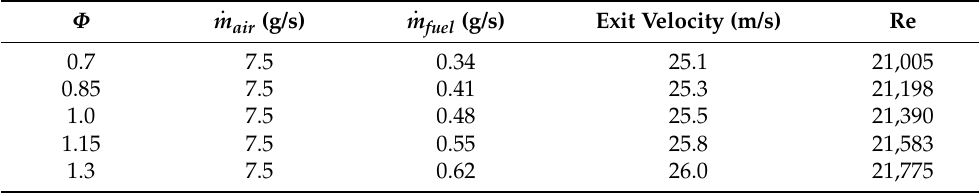
Table 1. Experimental Test